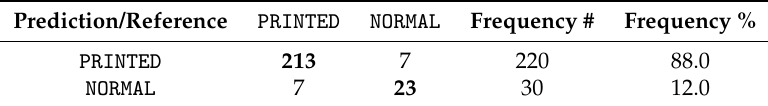
Table 6. Results on prints classification on an unseen validation dataset, performed by Adidas team. The numbers of correct predictions per class (on the main diagonal of the matrix) are highlighted in boldface